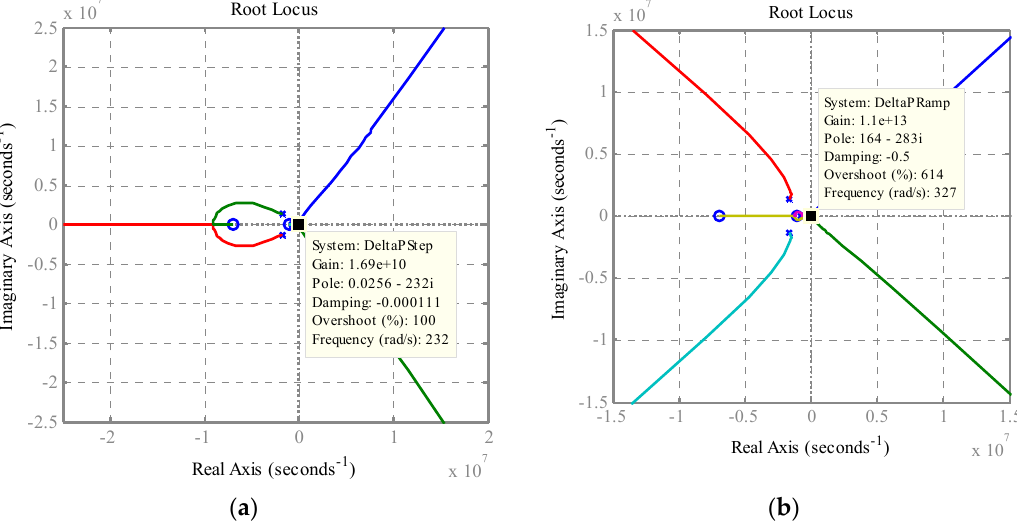
Figure 6. Root Locus diagrams of reactive power in Q / ∆ P : ( a ) Step active power error and ( b ) ramp active power error.